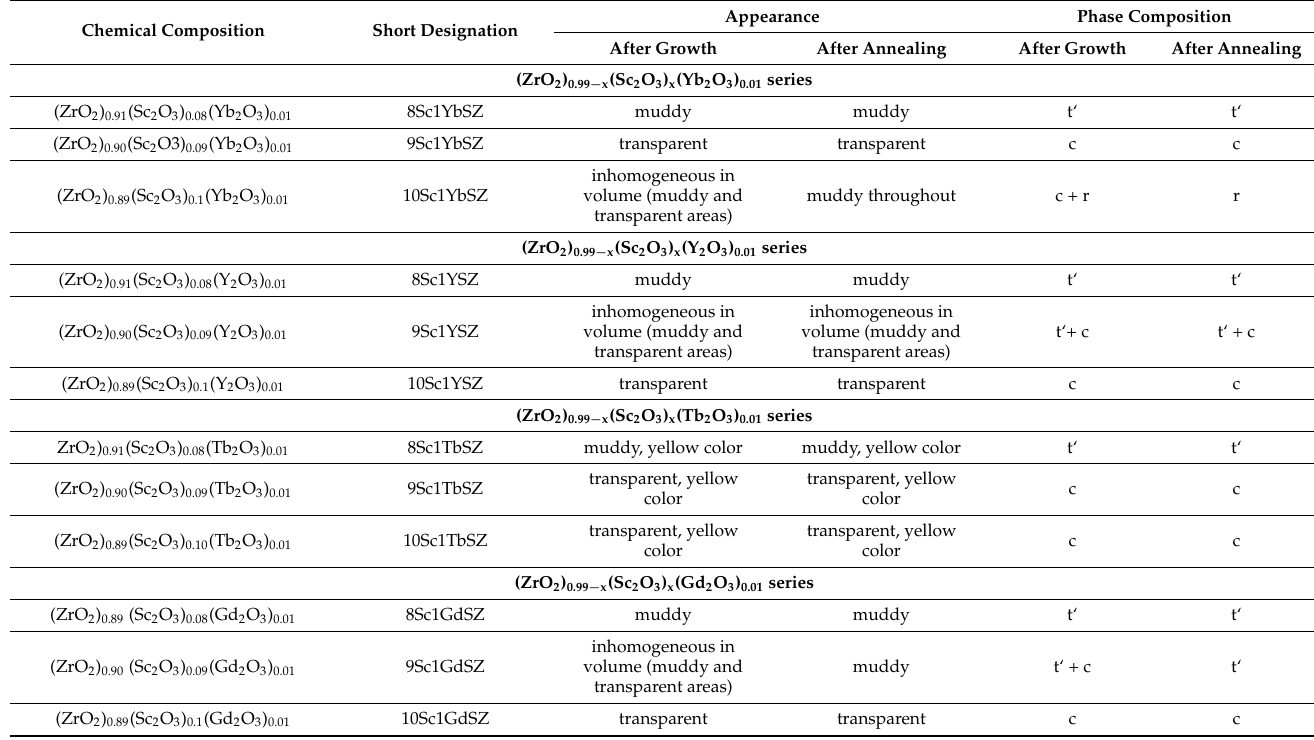
Table 1. Chemical and phase compositions of grown crystals, their designations, and appearance